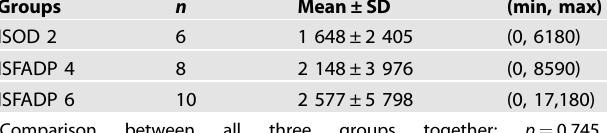
Table 3. Post-treatment costs per group (Euro).